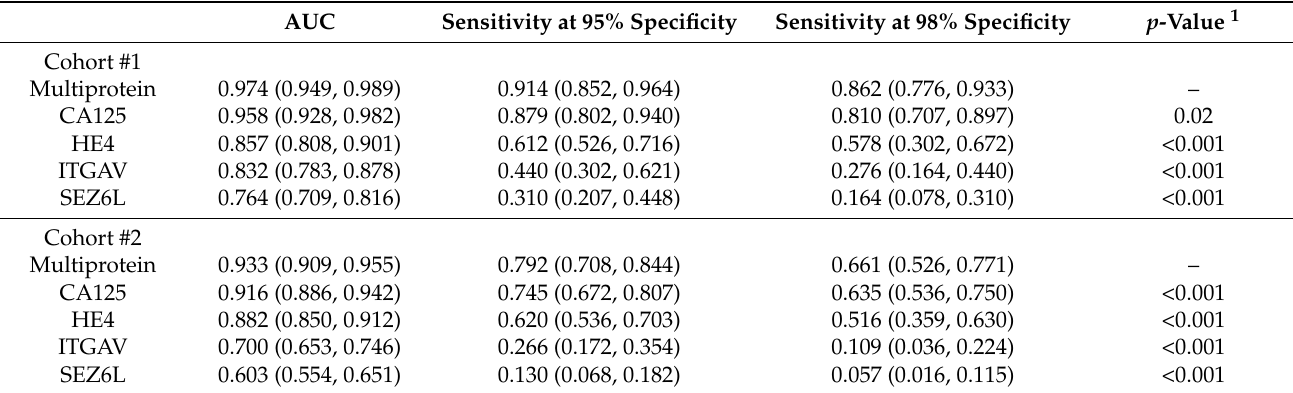
Table 4. Area under the curve (AUC) and sensitivities at 95% and 98% specificity (with 95% confidence intervals (CIs)) for the multiprotein classifier and the individual protein components for Cohorts #1 and #2. AUC Sensitivity at 95% Specificity Sensitivity at 98% Specificity p -Value